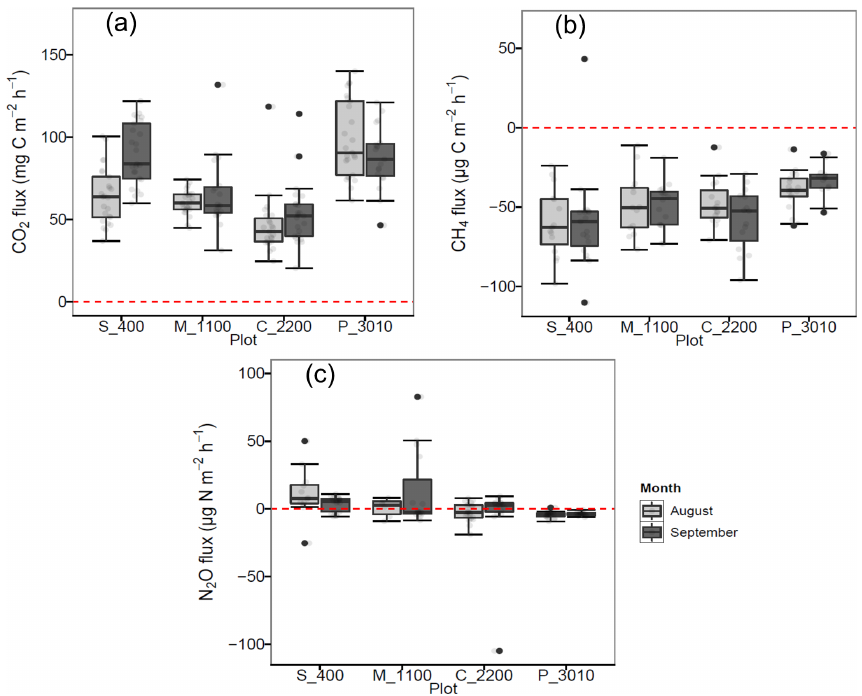
Figure 1. (a) Soil CO 2 (mgCm − 2 h − 1 ), (b) CH 4 (µgCm − 2 h − 1 ), and (c) N 2 O (µgCm − 2 h − 1 ) fluxes per month at Río Silanche (400ma.s.l.; S_400), Milpe (1100ma.s.l.; M_1100), El Cedral (2200ma.s.l.; C_2200), and Peribuela (3010ma.s.l.; P_3010). Light gray boxplots indicate the fluxes in August 2018, whereas dark gray boxplots indicate the fluxes in September 2018. Light gray dots in each boxplot represent the measurements taken each day and black dots the outliers of the respective site. The dotted red line across the boxes indicates zero net flux. Table 1. Average measurements plus or minus the standard deviations (SDs) of soil CO 2 , CH 4 , and N 2 O fluxes at Río Silanche